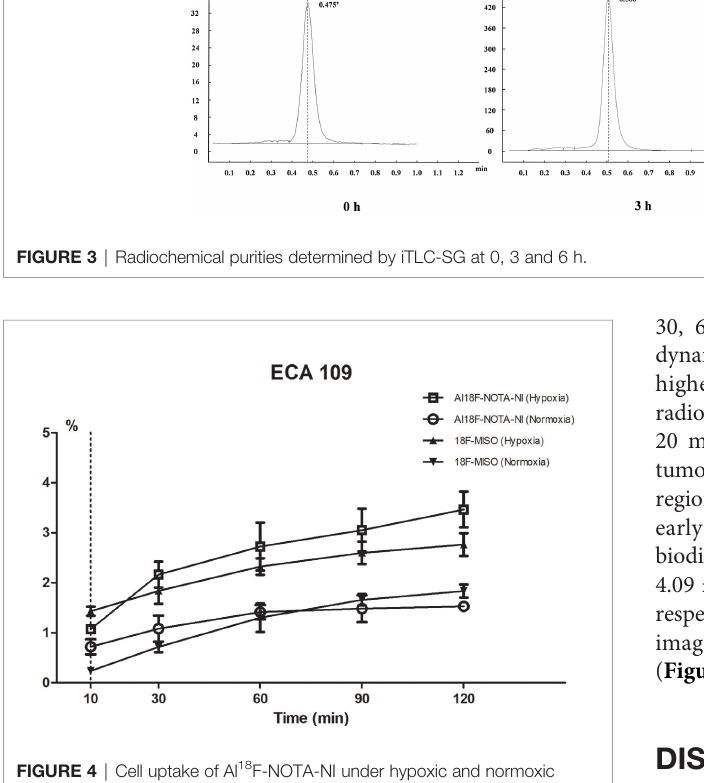
FIGURE 4 | Cell uptake of Al 18 F-NOTA-NI under hypoxic and normoxic conditions (n = 4 per time point).